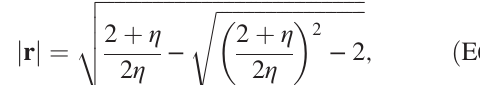
ffiffiffiffiffiffiffiffiffiffiffiffiffiffiffiffiffiffiffiffiffiffiffiffiffiffiffiffi (cid:1) 2 þ η